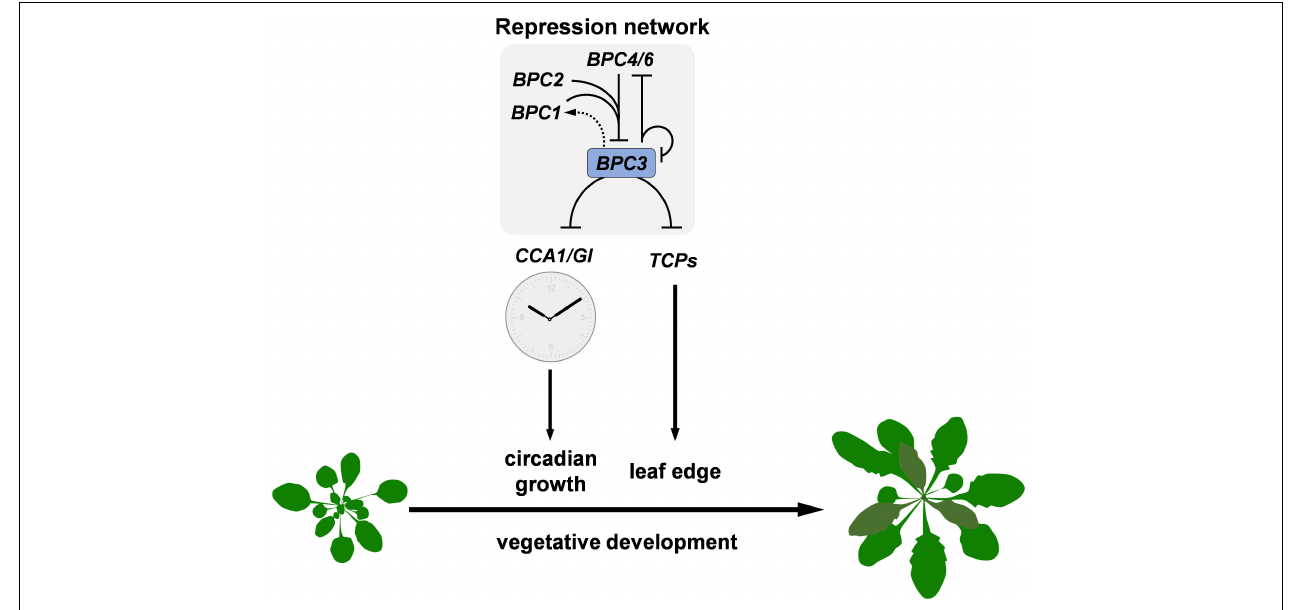
FIGURE 9 | Diagram depicting the repression machinery constituted by BPC members in Arabidopsis vegetative development. Family members BPC1, BPC2, BPC3, BPC4, and BPC6 additively formed a repression network to limit BPC3 expression during the vegetative development. The concurrent mutations on BPC1 , BPC2 , BPC4 , and BPC6 cause the relief of repression on BPC3 . The ectopic BPC3 represses multiple clock genes including CCA1 and GI , resulting in the retardation of circadian growth. Simultaneously, BPC3 impedes the formation of leaf edge via repressing a subset of TCPs essential for leaf development. The reciprocal regulations between BPC members are marked with black lines with arrows (positive) or blunt ends (negative) according to the genetic study by Monfared et al. (2011) and BPC3/4 functional assays in this study. BPC3 may activate BPC1 via an indirect mechanism marked as a dashed arrow.